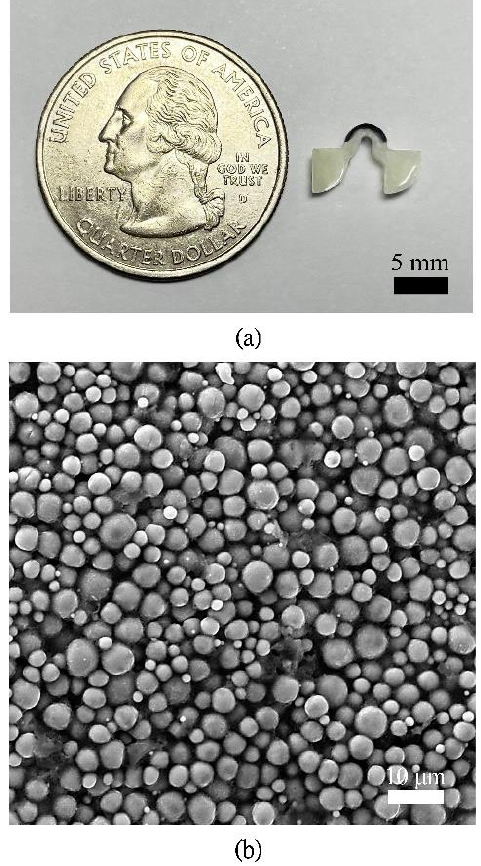
Figure 4. Fabrication results: ( a ) picture of the fabricated LCE device; ( b ) SEM image of the top surface of the LCE device deposited with PTF.